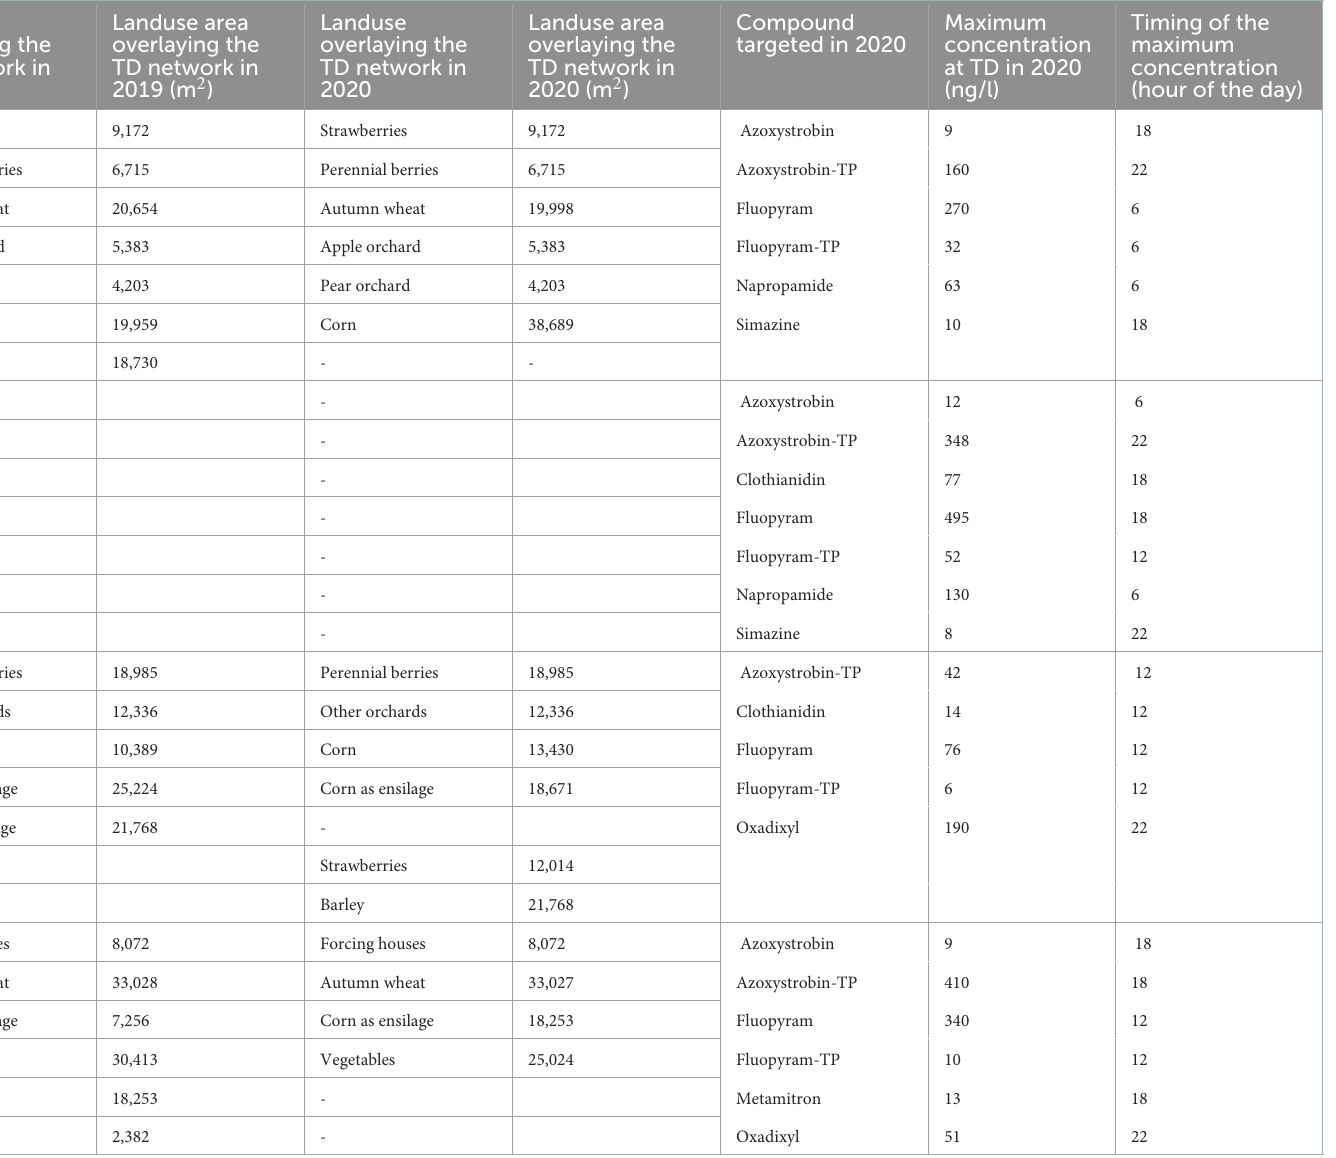
TABLE 5 Maximum concentrations of the target compounds measured at the tile drain outlets during the dry-day campaign in 2020. Identifier of the tile drain